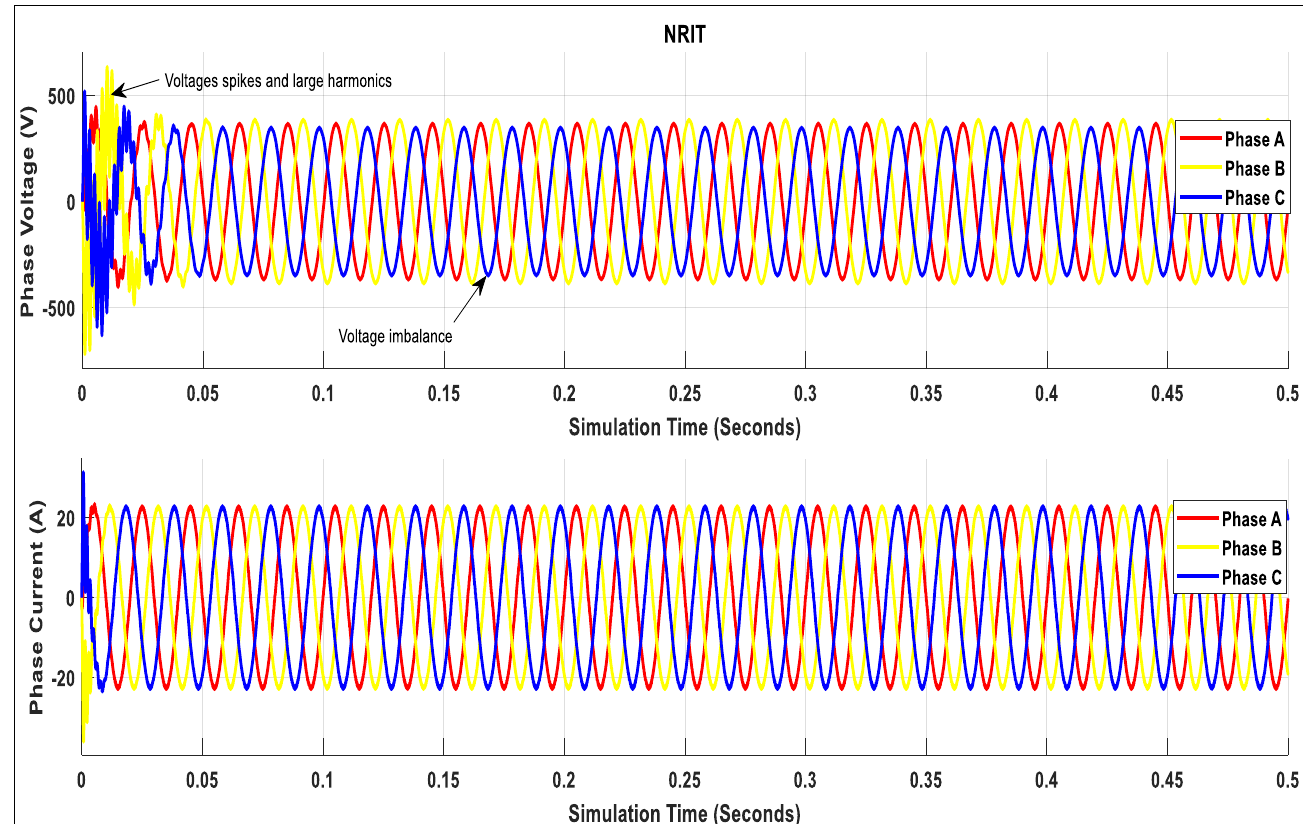
Figure 23. Three-phase grid voltages and current with NRIT.